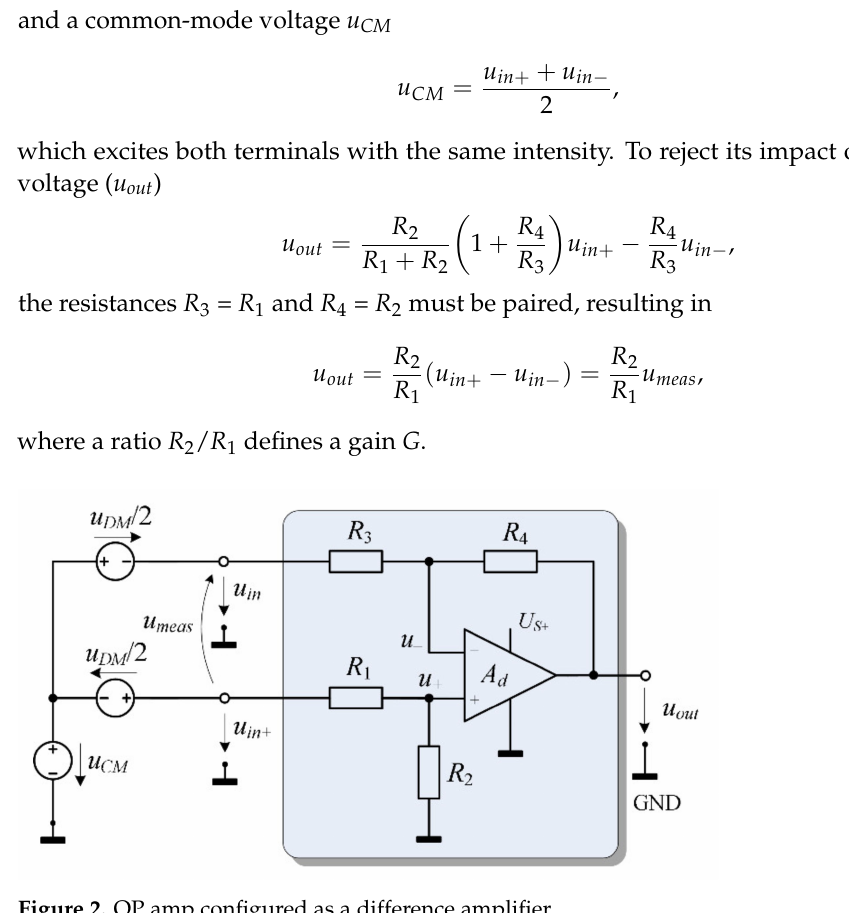
Figure 2. OP amp configured as a difference